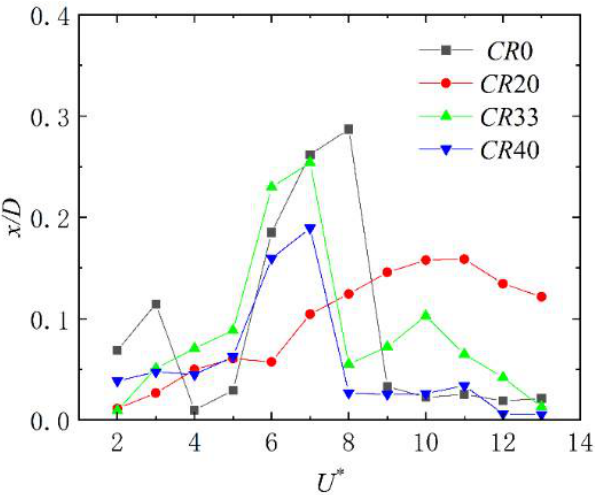
Figure 13. Vibration amplitude of a cylinder with surface bulges in streamwise direction.